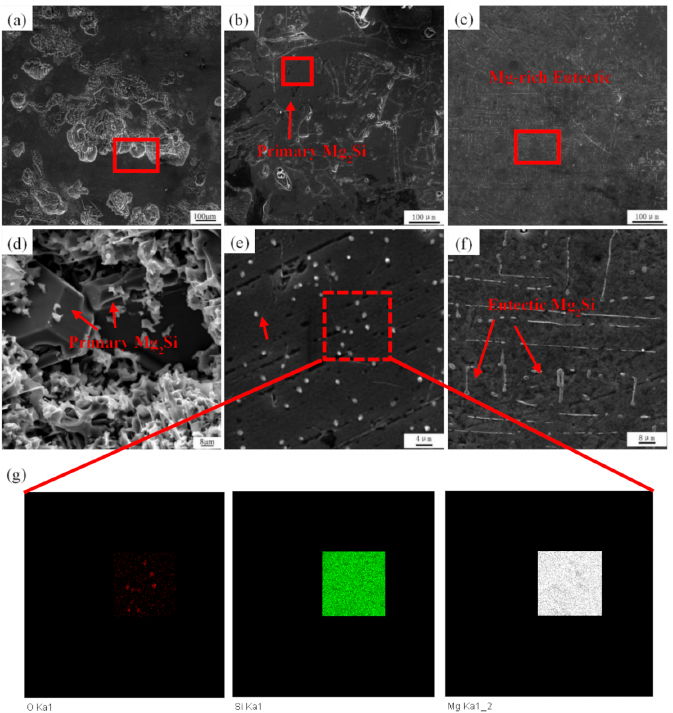
Figure 5. The surface morphologies of chemically cleaned specimens after 7 days immersion ( a , d ) MS8; ( b , e ) GMS-1;( c , f ) GMS-2; ( g ) EDS map result of red square in ( e